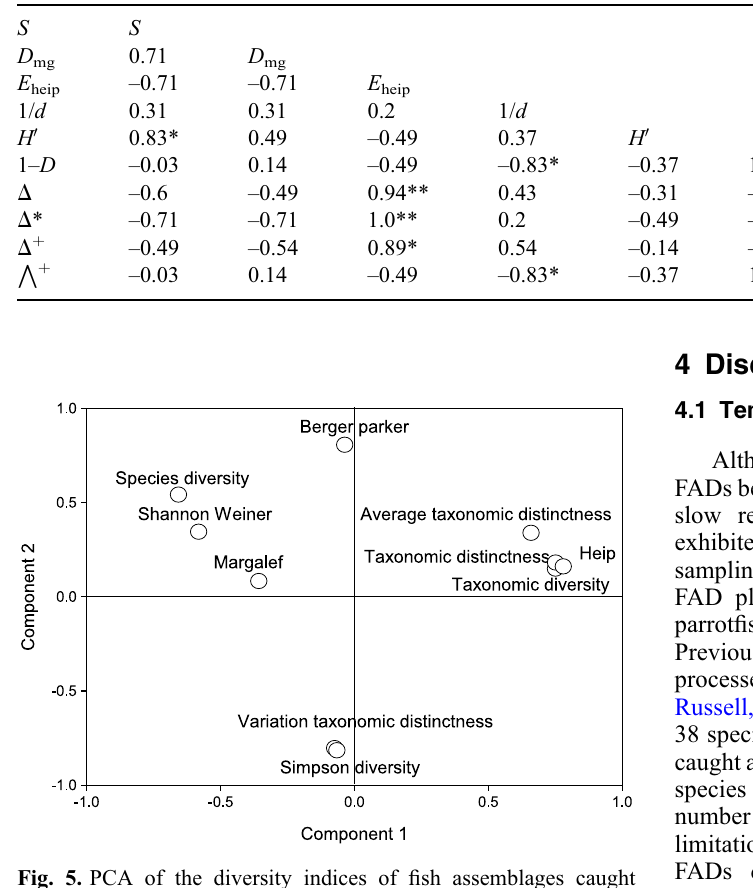
Table 4. Spearman's rank correlation matrix between the 10 selected diversity indices. All signi fi cant correlations are marked by an asterisk